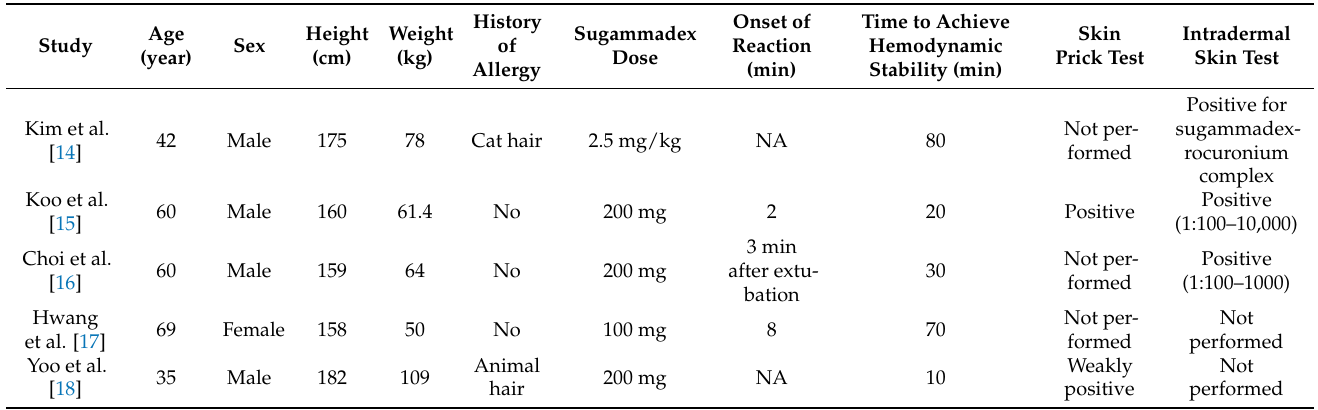
Table 2. Summary of sugammadex-induced anaphylaxis case reports published by Korean